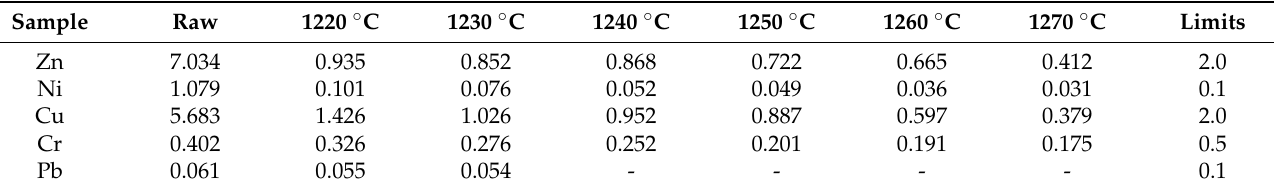
Table 4. Leaching concentrations in the ceramsites